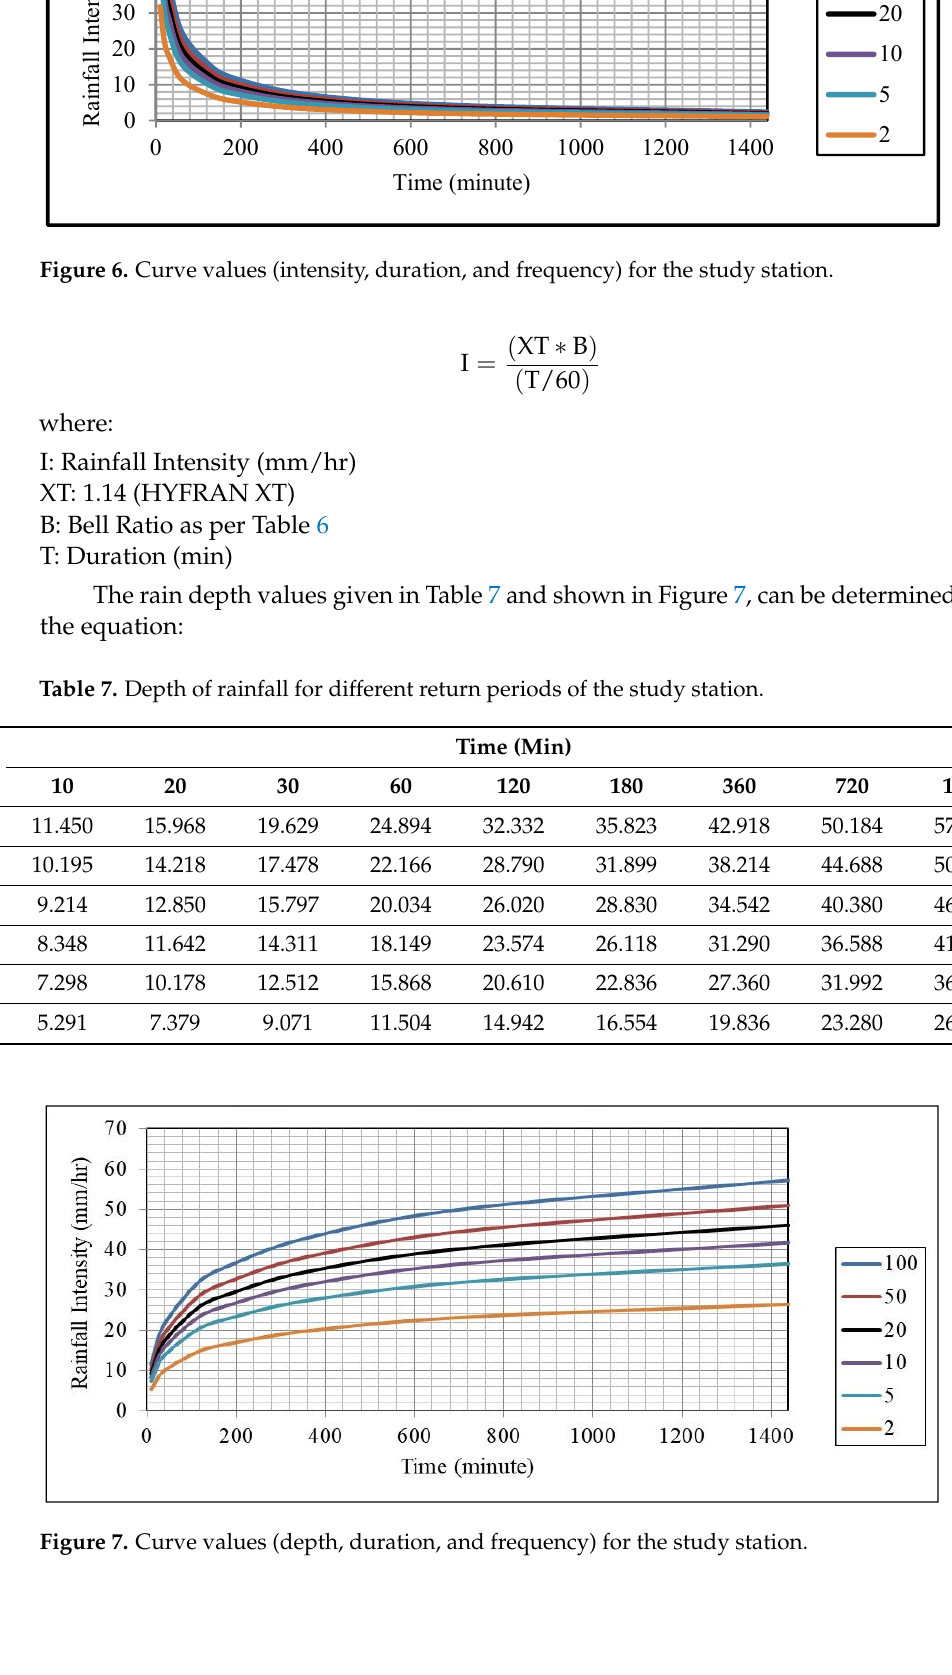
Figure 7. Curve values (depth, duration, and frequency) for the study station.